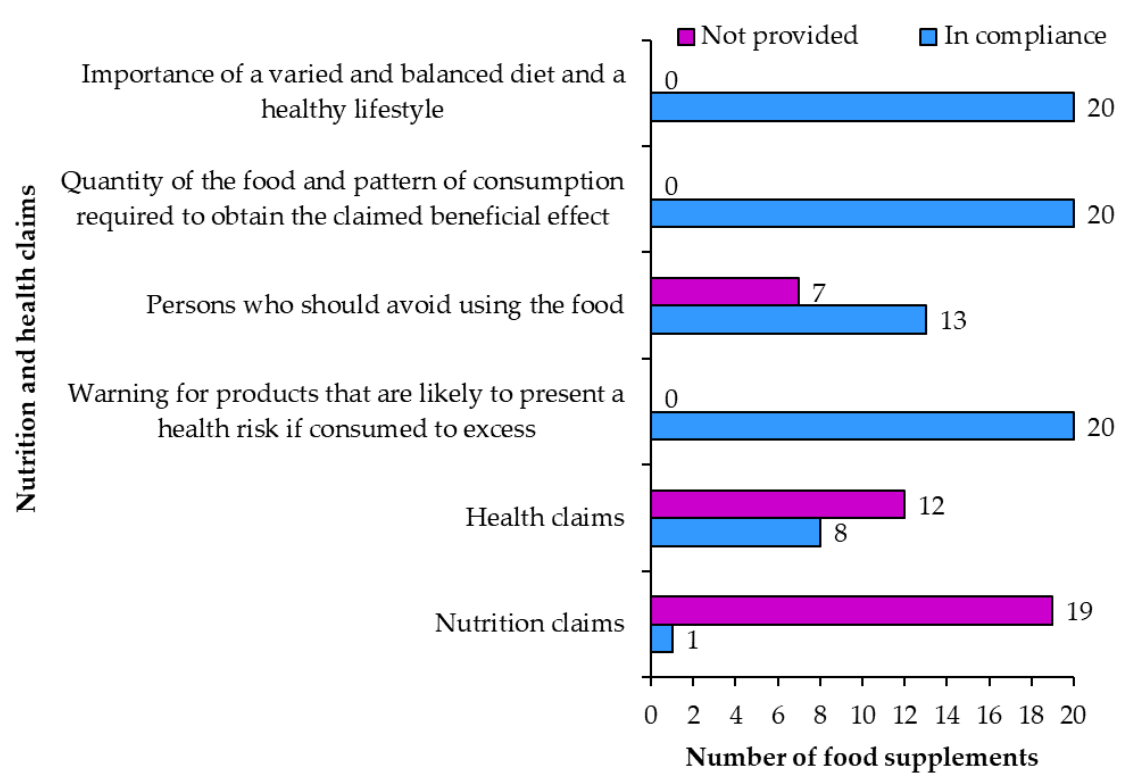
Figure 10. Food supplements with health and nutrition claims.